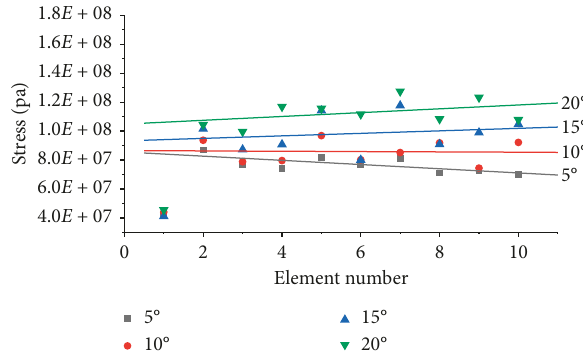
Figure 14: The average stress of representative elements under different tool back angles ( H